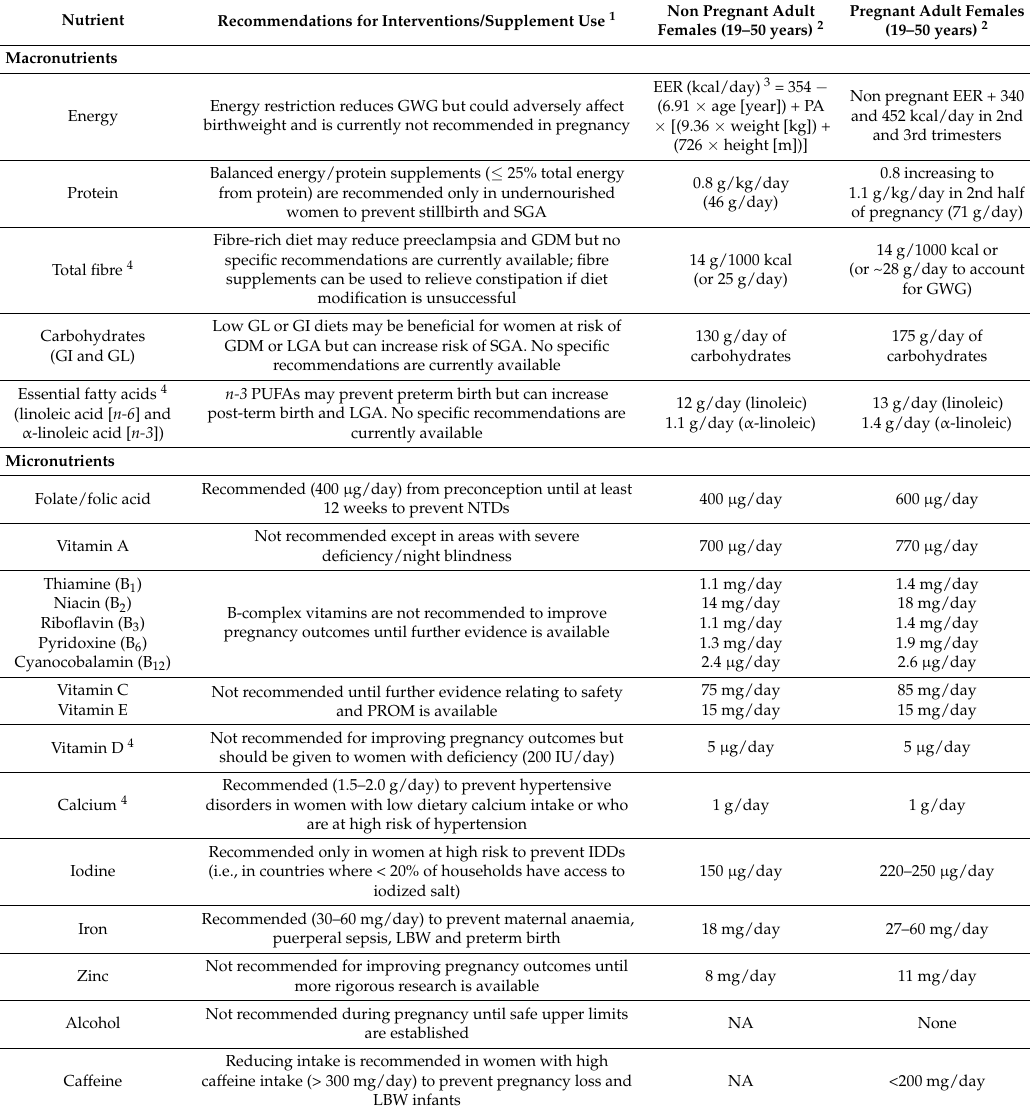
Table 1. Summary of evidence regarding macronutrient and micronutrient intakes during